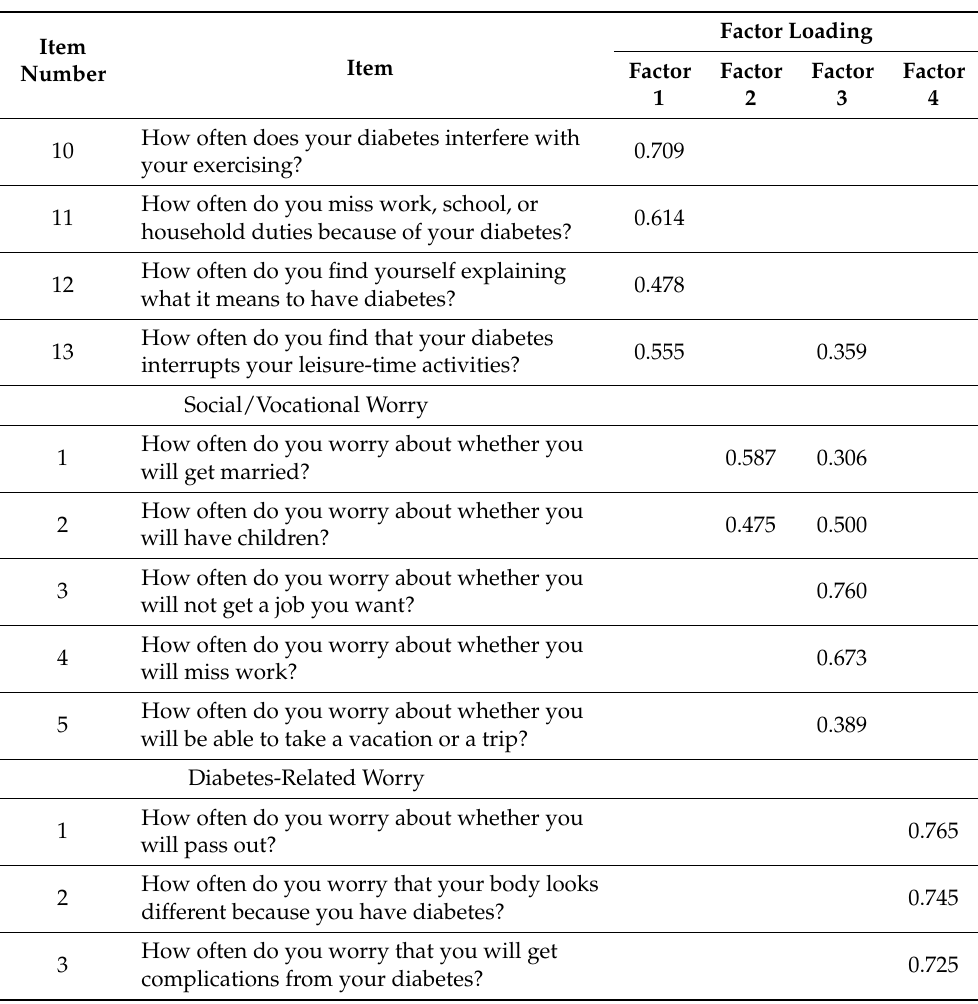
Table 4. The diabetes quality of life-Afaan Oromoo version (in Afaan Oromoo) among people living with type 2 diabetes attending Nekemte Specialized Hospital, 2020 ( n =